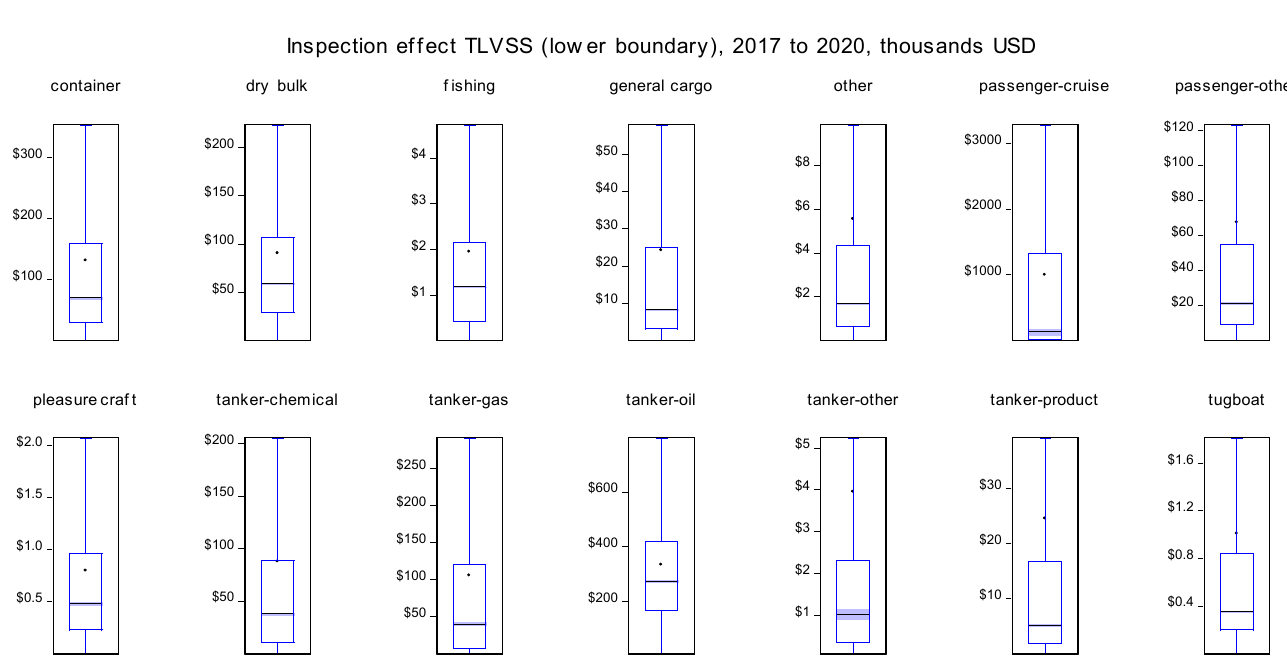
Figure A2. Boxplots of MVR (TLVSS) and inspection effect (averted incident costs).